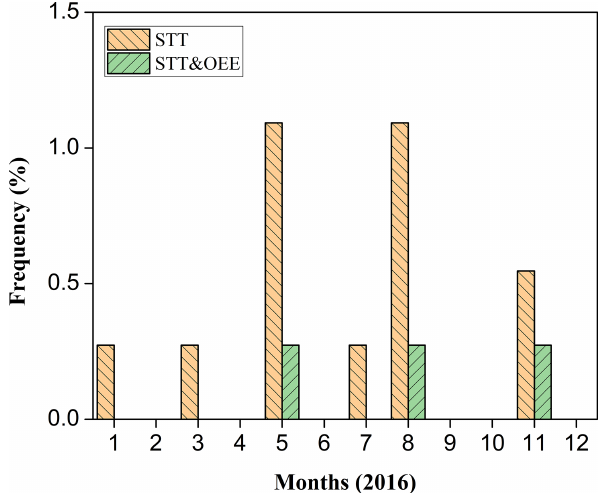
Figure 11. Annual variation in deep STT events at Kunlun Station and the annual variation in it that occurred at the same time as OEEs over the period 2016, obtained by